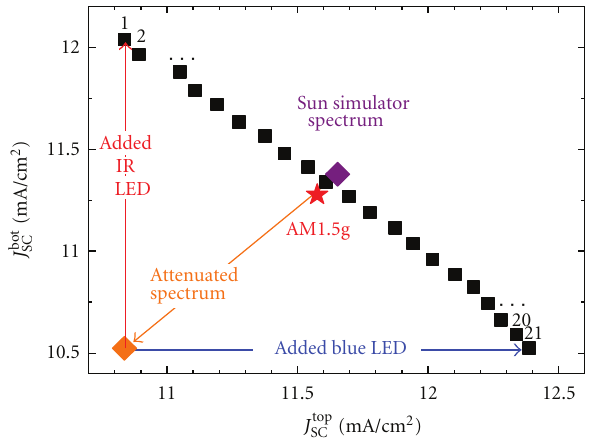
F 5: e current density difference early as a function of the index by (3). e gray dashed line is a linear �t. e AM1.5g-illumination conditions are most closely met for measurement number marked in red. e subcell currents are equal, approximately for measurement number